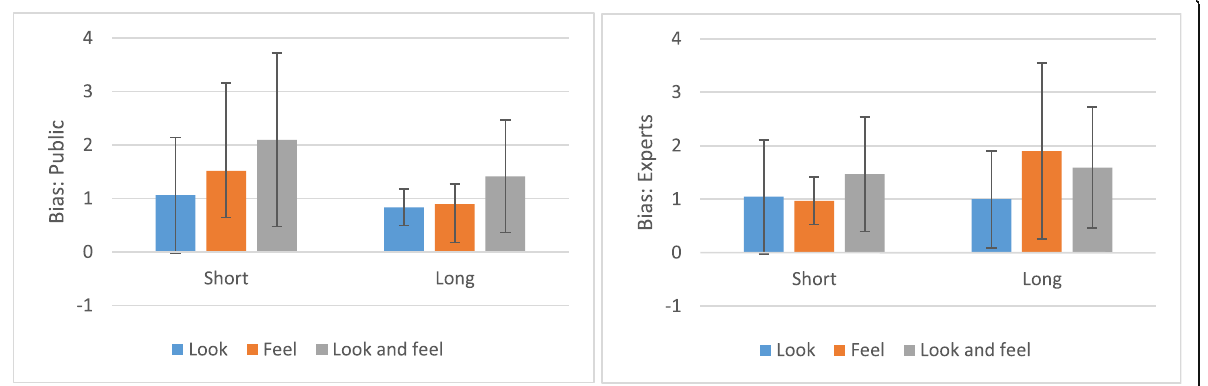
Fig. 8 Average response biases and their error bars (standard deviation (SD)) as a function of expertise and perceptual